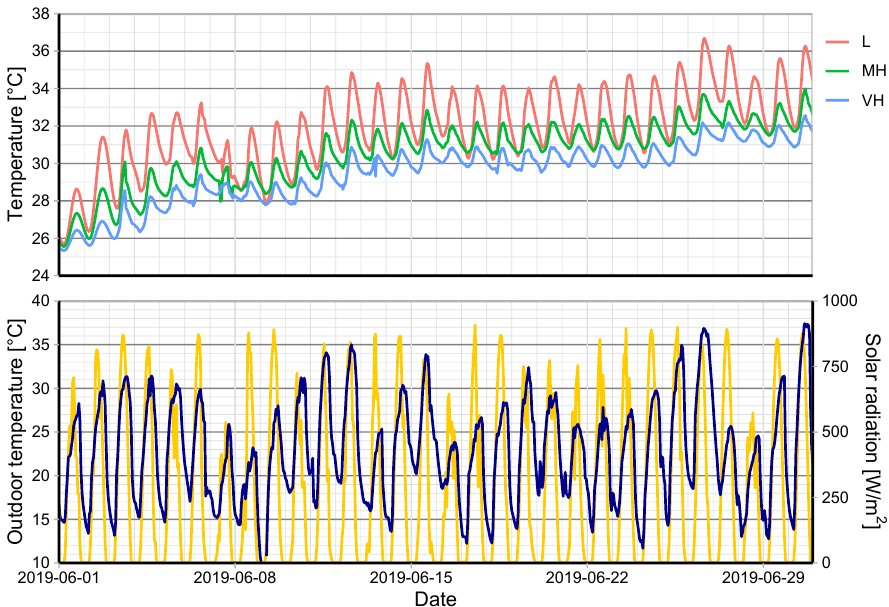
Figure 4. The temperature course in light, medium heavy, and very heavy rooms as a function of outdoor temperature and solar radiation during heat wave 1 through 30 June 2019.